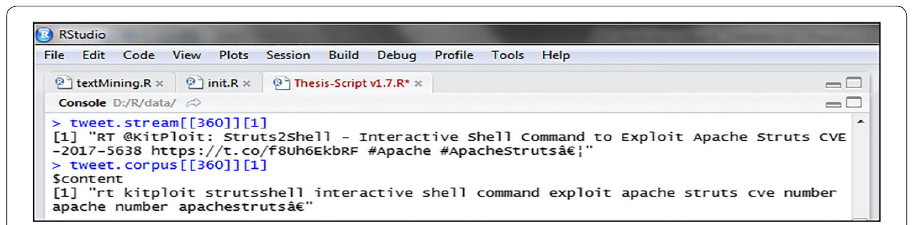
Fig. 4 Cleaned and organized text examples. This is to give an example of the cleaned and organized data for the next